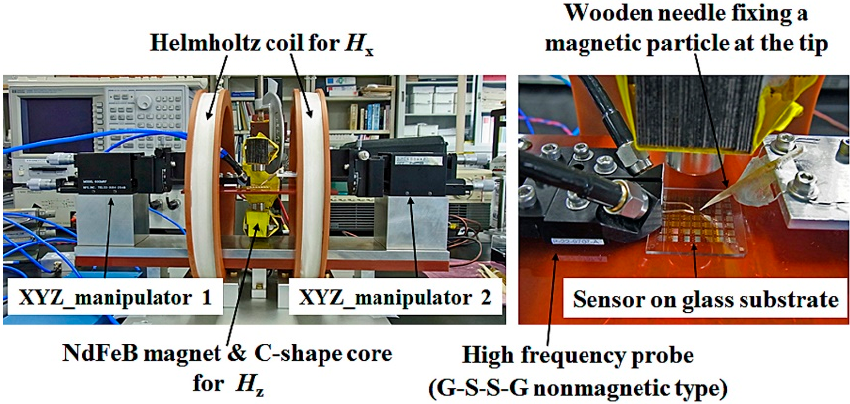
Figure 30. Photograph of measurement system of the differential detection experiment. Figure 31 is a 2D-mapping of a measured signal, when a particle having a diameter of 200 µ m was scanned on the sensor substrate with the height of 1 mm. There is an extreme value just above the right edge of the sensor element, and the polarity was opposite on the differential pair sensor. The measurement was restricted in the left half region, due to the existence of contact needles of wafer probe, but the result is easily estimate on the left